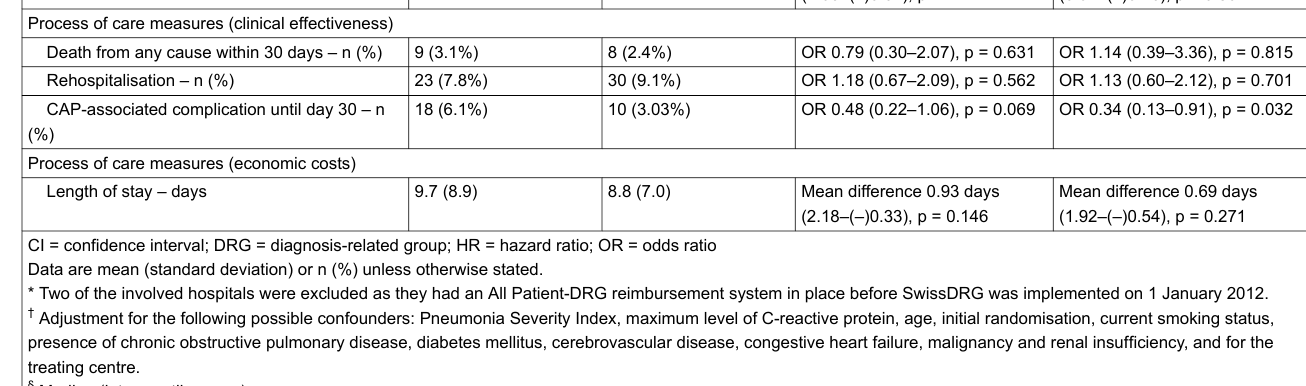
Rehospitalisation – n